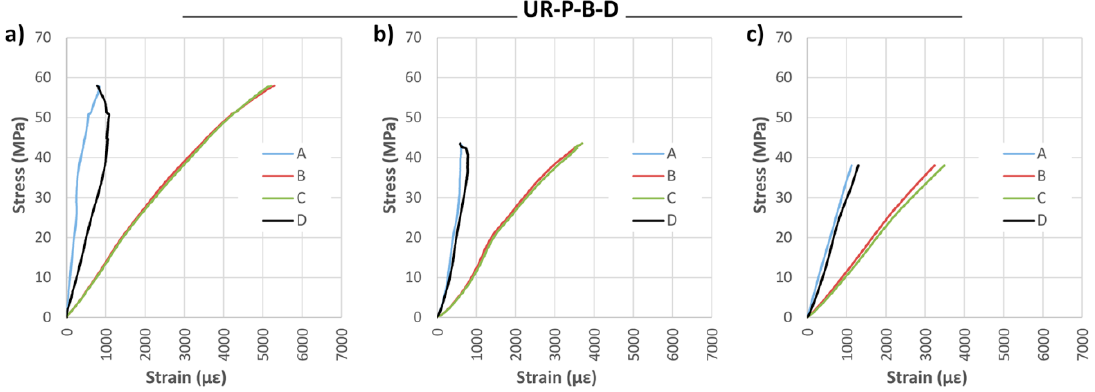
Figure 21. Stress against strain during bending tests: ( a ) UR-P-B-D-1; ( b ) UR-P-B-D-2; and ( c ) UR-P-B-D-3. CFRP supplier: DRIZORO ®